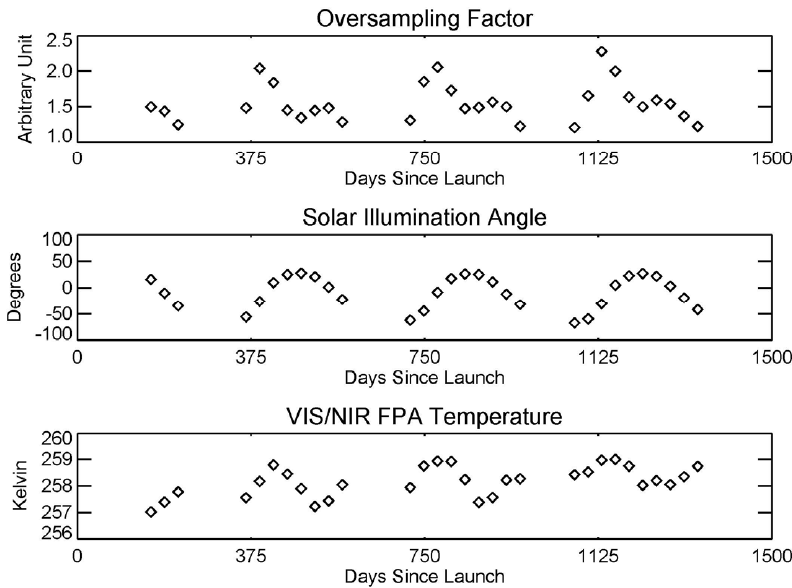
Figure 5. The definition of the solar illumination angle in FPA coordinates. The number at the bottom left corner of each plot is the angle for that event.